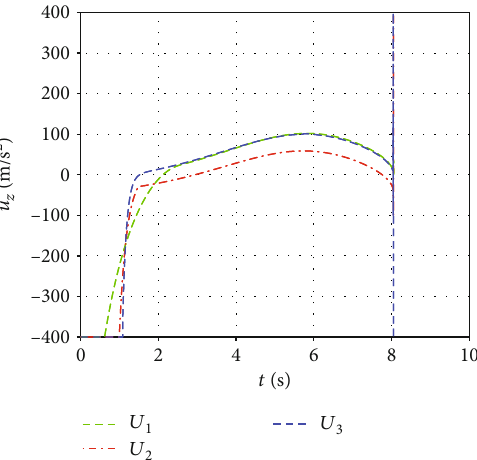
Figure 10: Acceleration instruction u